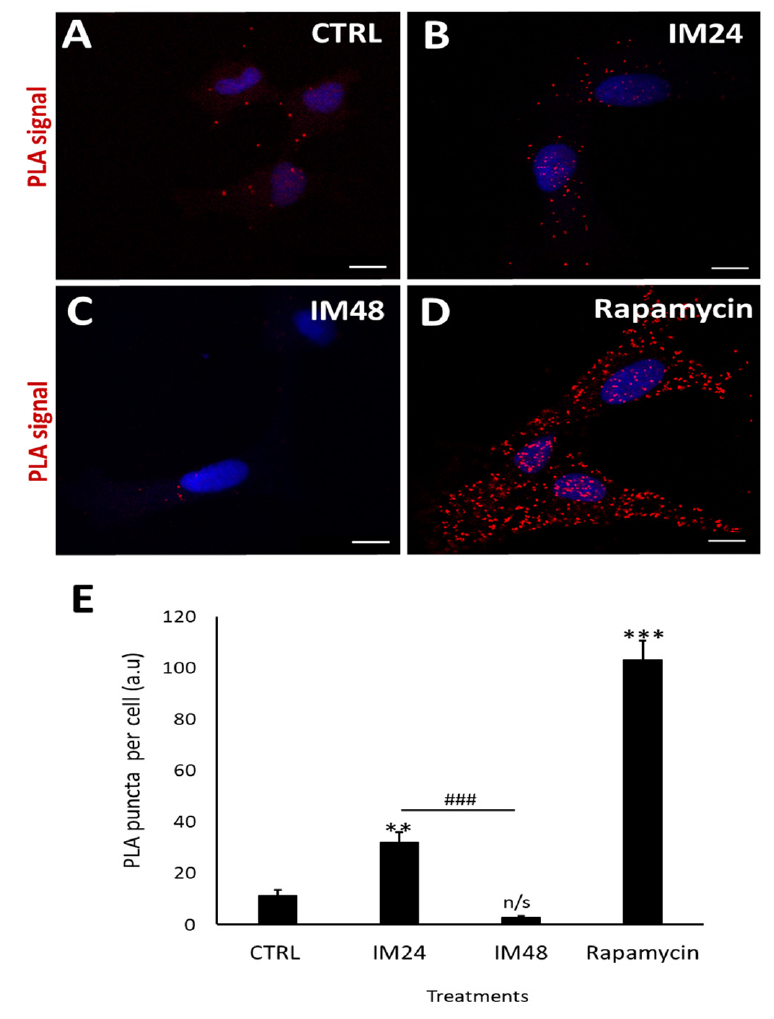
Figure 5. IM reduces LC3/p62 colocalisation in hCPCs. ( A – D ) PLA-representative images of control cells (low PLA signal), IM 24 h increased signal, IM 48 h reduced signal, and rapamycin high-PLA red puncta (arrows). ( E ) Quantification of PLA puncta after treatment with: IM 24 h, IM 48 h, and rapamycin 4 h. Data are mean ± SEM, n = 10; ** p < 0.05 and *** p < 0.001 vs. control; ### p < 0.001 vs. IM 24 h treatment. Scale bars = 10 µm. n/s = not significant vs. control.